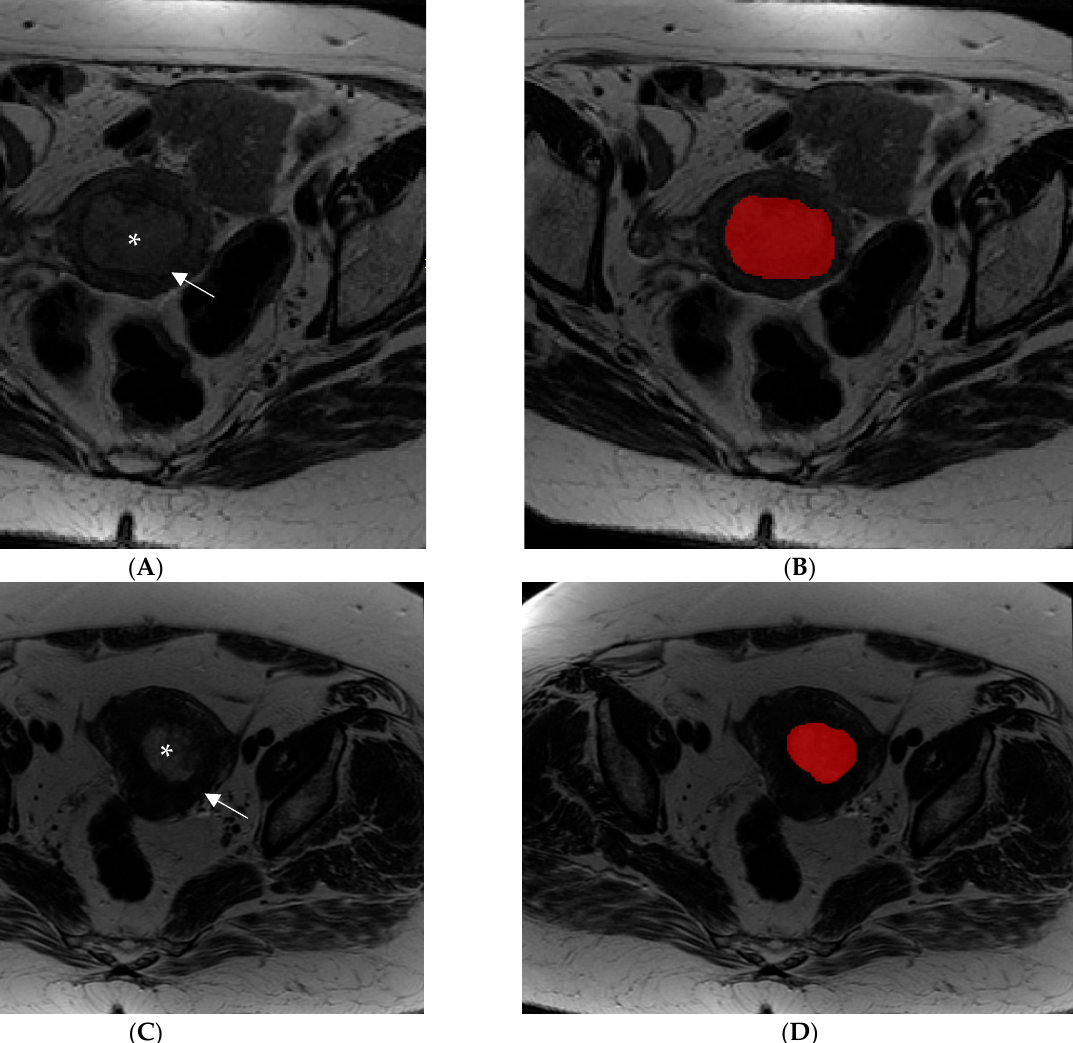
Figure 1. Examples of manual segmentation of endometrial tumors observed by MRI using an Axial Fast Spin Eco T2-weighted image acquisition sequence. ( A , B ) Images show an intermediate signal intensity lesion (asterisk) causing more than 50% myometrial invasion (arrow) in a patient with high-risk endometrial cancer before ( A ) and after ( B ) image segmentation. ( C , D ) Images show a patient with a low-risk endometrial tumor (asterisk) with less than 50% myometrial invasion (arrow) before ( C ) and after ( D ) image segmentation.